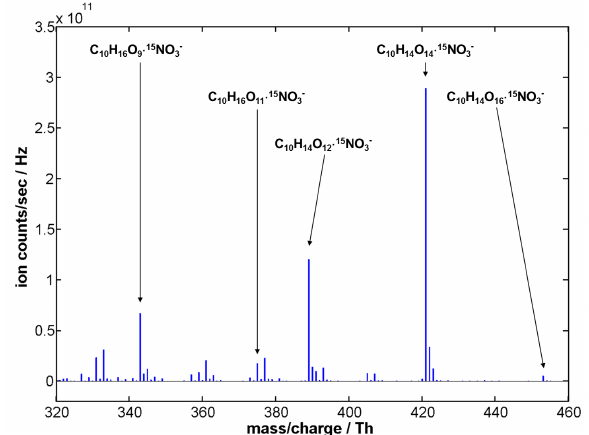
Figure 1. Spectrum of ozonolysis products of cyclopentene. The most abundant peroxy radical C 5 H 7 O 8 · 15 NO − tion products are marked as well as the next higher peroxy radical ( + 32Th) and termination products. The m/z differences in [Th] are indicated.